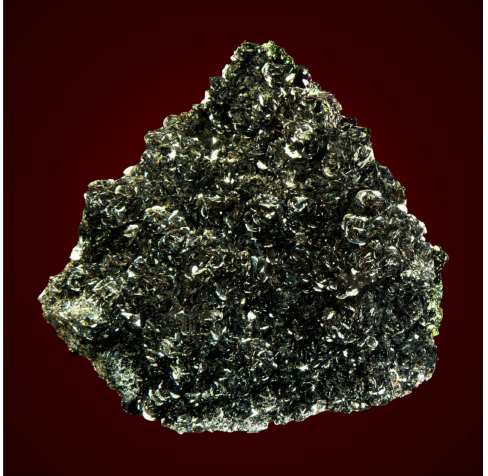
Figure 21. Hematite, Toothaker Creek prospect. 10 cm. Chamberlain Collection, NYSM 11650. SC.